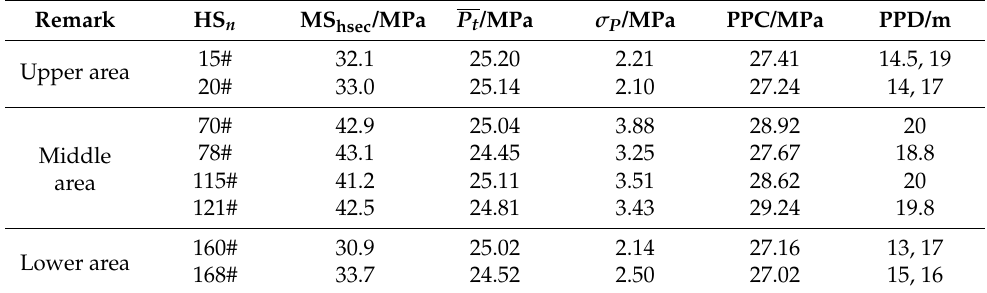
Table 1. Periodic pressure characteristic value of 42,114 working face monitoring